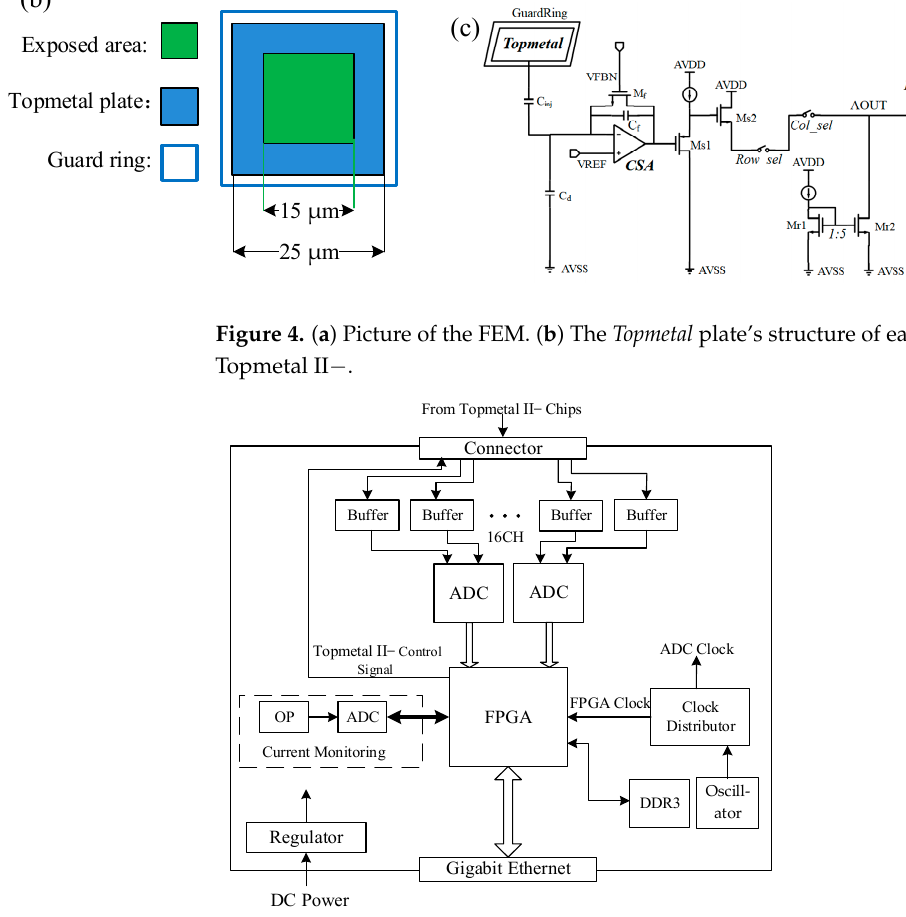
Figure 6. The picture of the RCM.